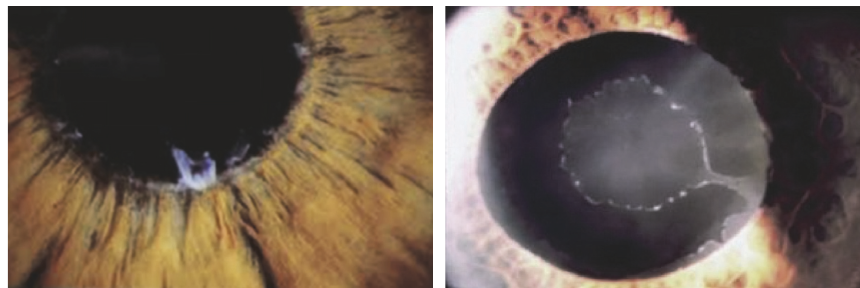
Figure 2: Pseudoexfoliation syndrome with grey-whitish flakes and PXF